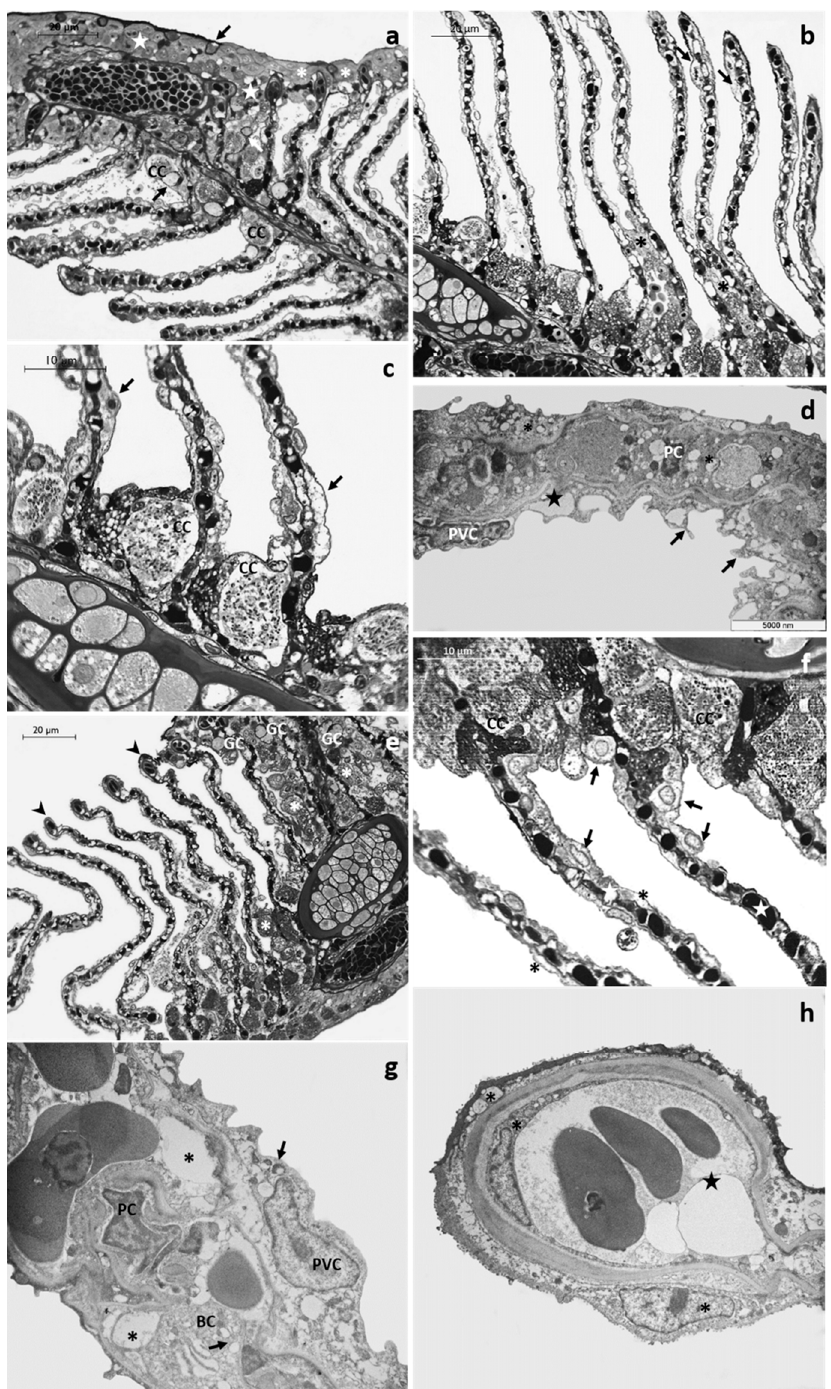
Figure 2. Representative micrographs of T. pavo gills after 48 ( a – d ) and 96 ( e – h ) hours of exposure to 4 µg/L of CPF. ( a ) Light micrograph showing the proliferation of primary epithelium (star) and the fusion of the lamellae in their apical portion (asterisks). Note the presence of goblet cells (black arrows) in the proliferative region of the main filament and in the interlamellar space; CC = chloride cell. ( b ) Note the main epithelium extending throughout the interlamellar area (asterisks) and lacunae’s appearance in the secondary epithelium (black arrows). ( c ) Detail of chloride cells (CC) characterized by a poor cytoplasm; also note the lacunae in the secondary filament (black arrows). ( d ) TEM micrograph showing cytoplasmic projections originating from pavement cells (black arrows) and the highly vacuolated cytoplasm of both epithelial and endothelial cells (asterisks); star = lacunae, PVC = pavement cell, PC = pillar cell. ( e ) Light micrograph showing the proliferation of primary epithelium (asterisks) and